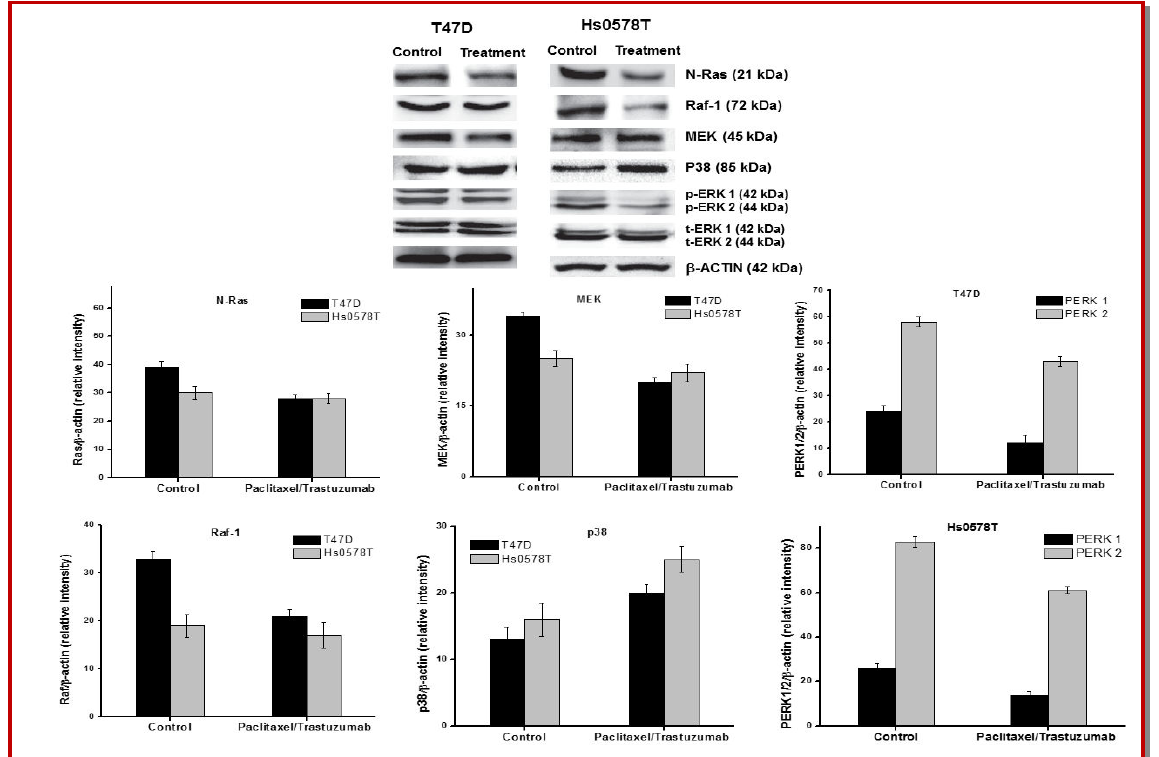
Figure 2: Effect of paclitaxel and trastuzumab treatment on various protein expression in MAPK pathway in T47D and Hs0578T